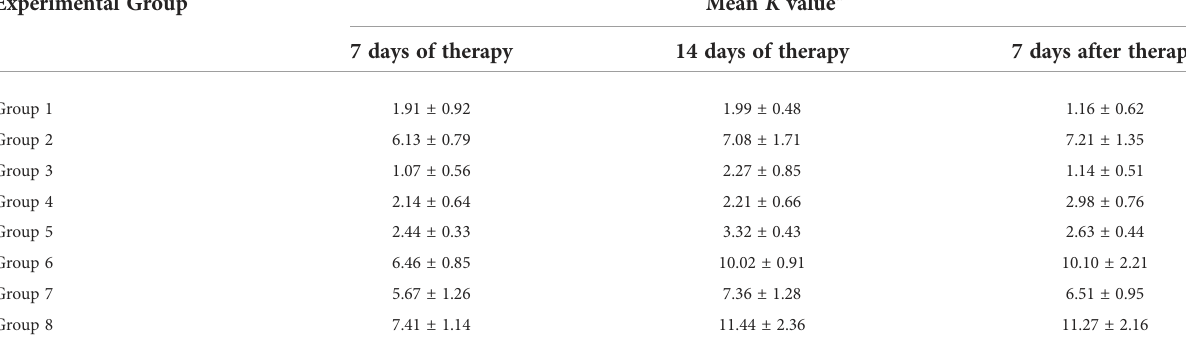
TABLE 1 Inactivation levels of phage vB_SenM-2 in chicken sera, as measured by determination of the K value. Mean of values with SD are shown. Experimental Group